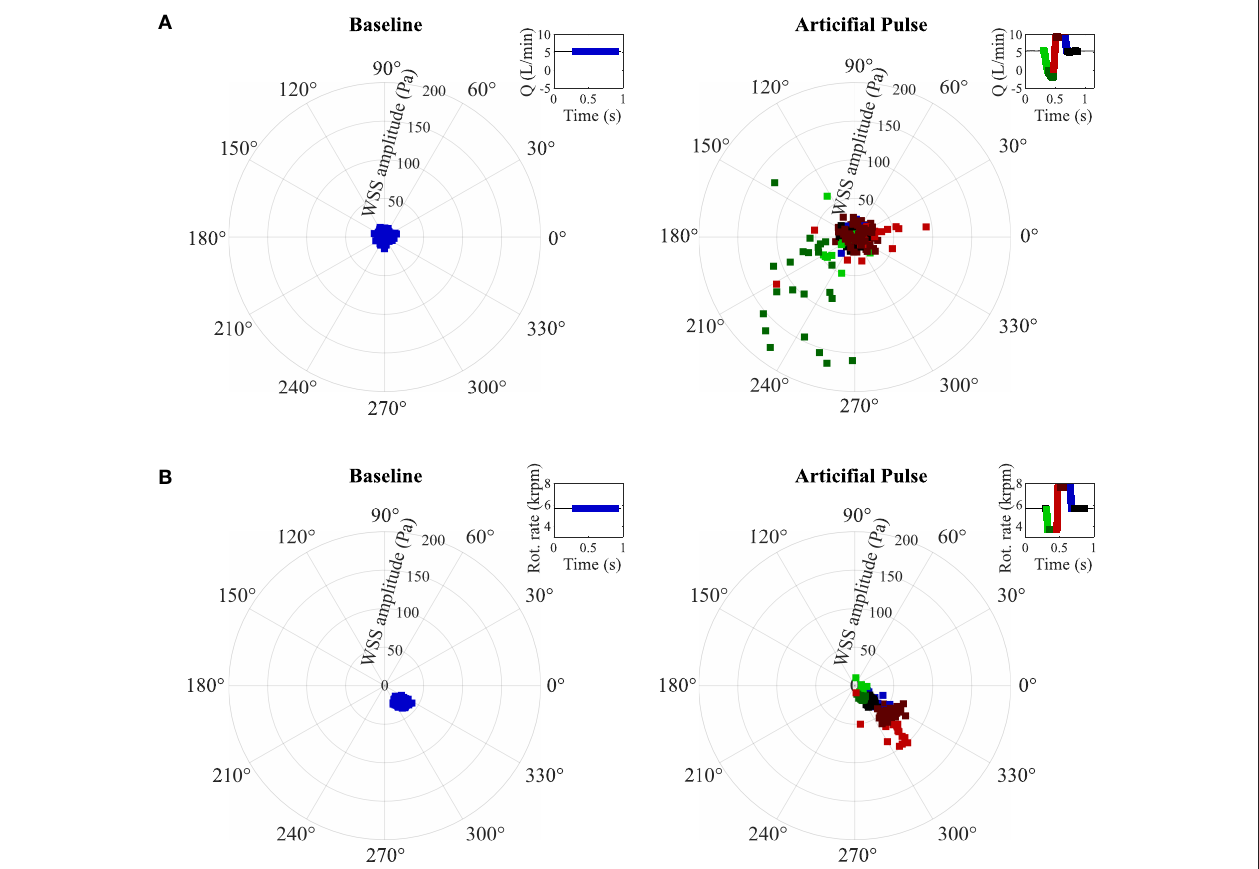
FIGURE 8 | Wall shear stress on the central points of (A) the bottom of casing and (B) the top of casing within secondary flow path. Five outliers in (A) (with WSS higher than 200Pa) are not shown. WSS: wall shear stress (see Supplementary Material S1 for the location of the WSS monitoring points).